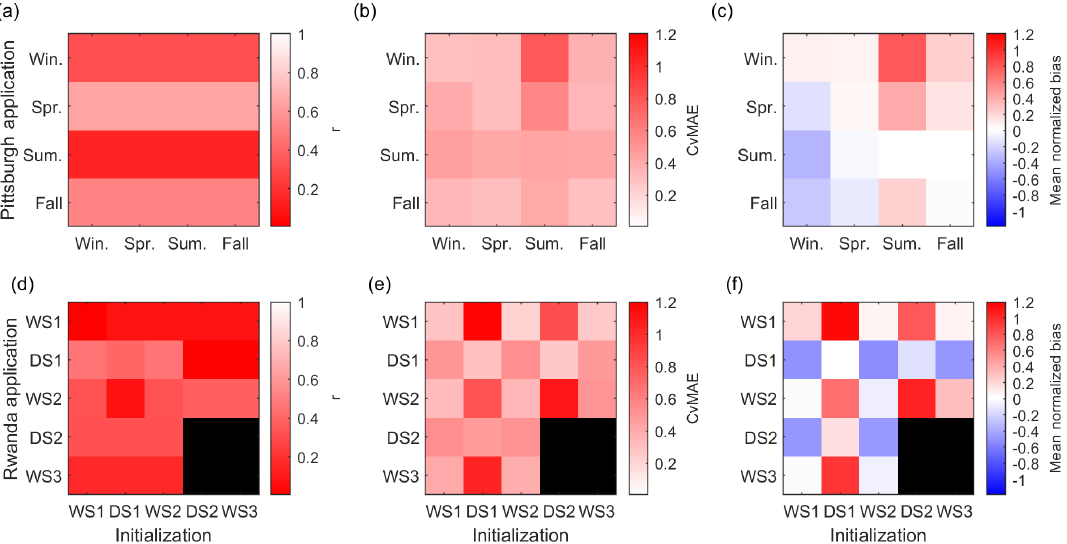
Figure 8. Comparison of seasonal performance metrics ( a, d correlation; b, e CvMAE; c, f MNB) for surface PM 2 . 5 estimated from satellite AOD data across different seasons in the Pittsburgh (a, b, c) and Rwanda (d, e, f) areas. The horizontal axis differentiates the seasons during which initialization was performed, while the vertical axis denotes the seasons when the conversion was applied. Note that, in Rwanda, only one sensor was operational during Dry Season 2 (DS2) and Wet Season 3 (WS3), so the application of these conversions to an independent site was impossible; therefore, performance metrics are blacked out. In each figure diagonal (from top left to bottom right) elements correspond to the same season. Values are also listed in the Supplement (Table